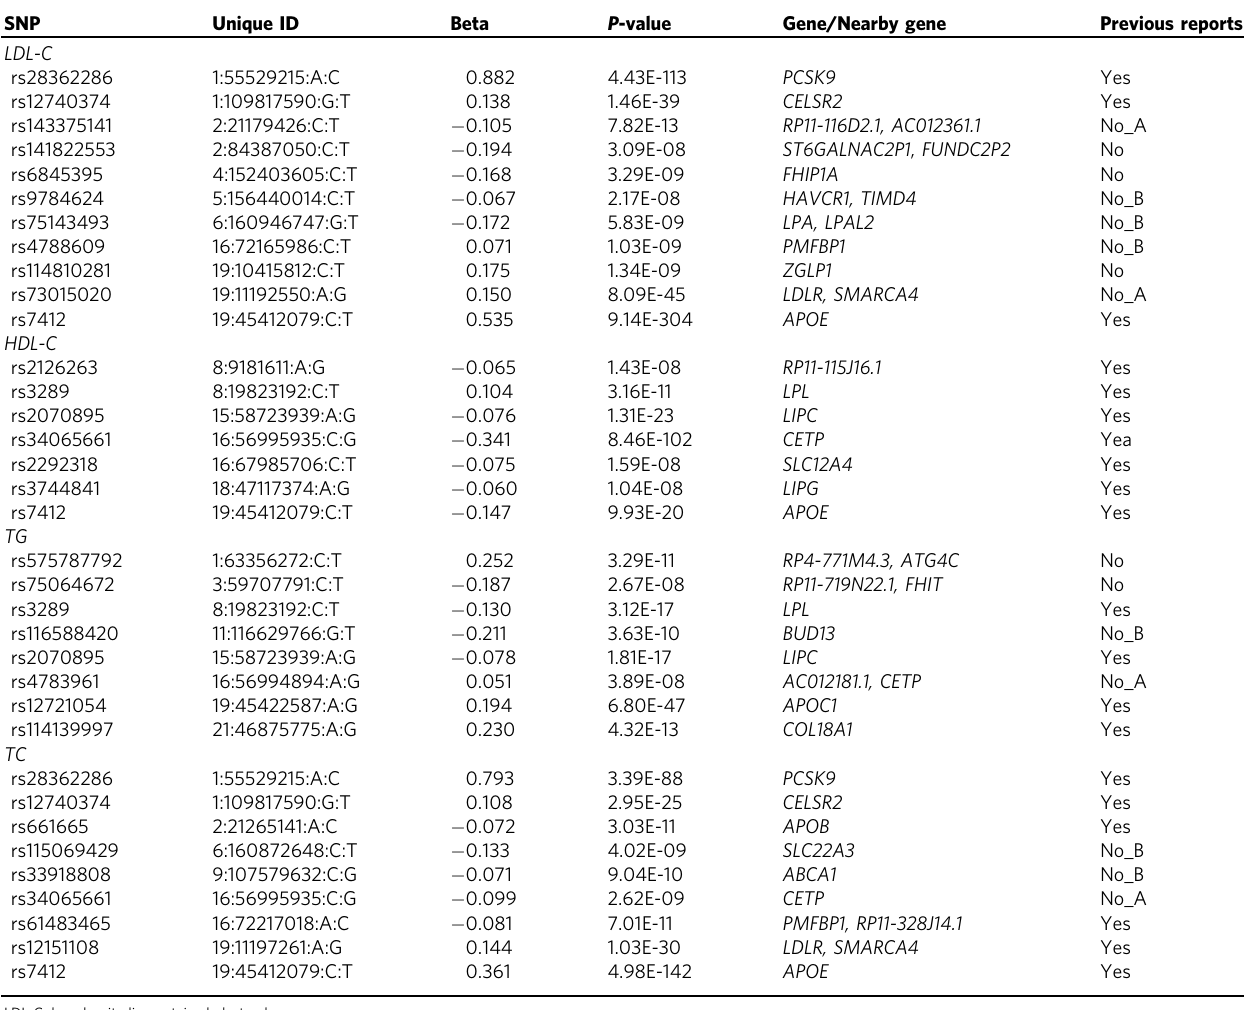
Table 2 Summary of associations detected in Stage 2 GWAS (meta-analysis of AWI-Gen and four other African cohorts). Additional details in Supplementary Data 6.